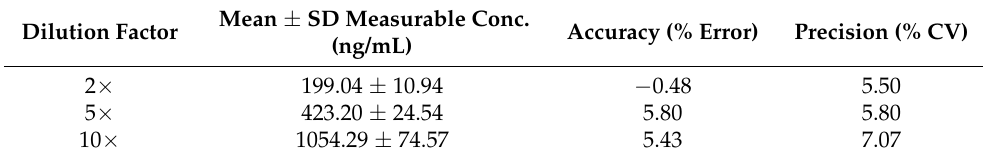
Table 4. Uji Dilution integrity glipizide in spike plasma.